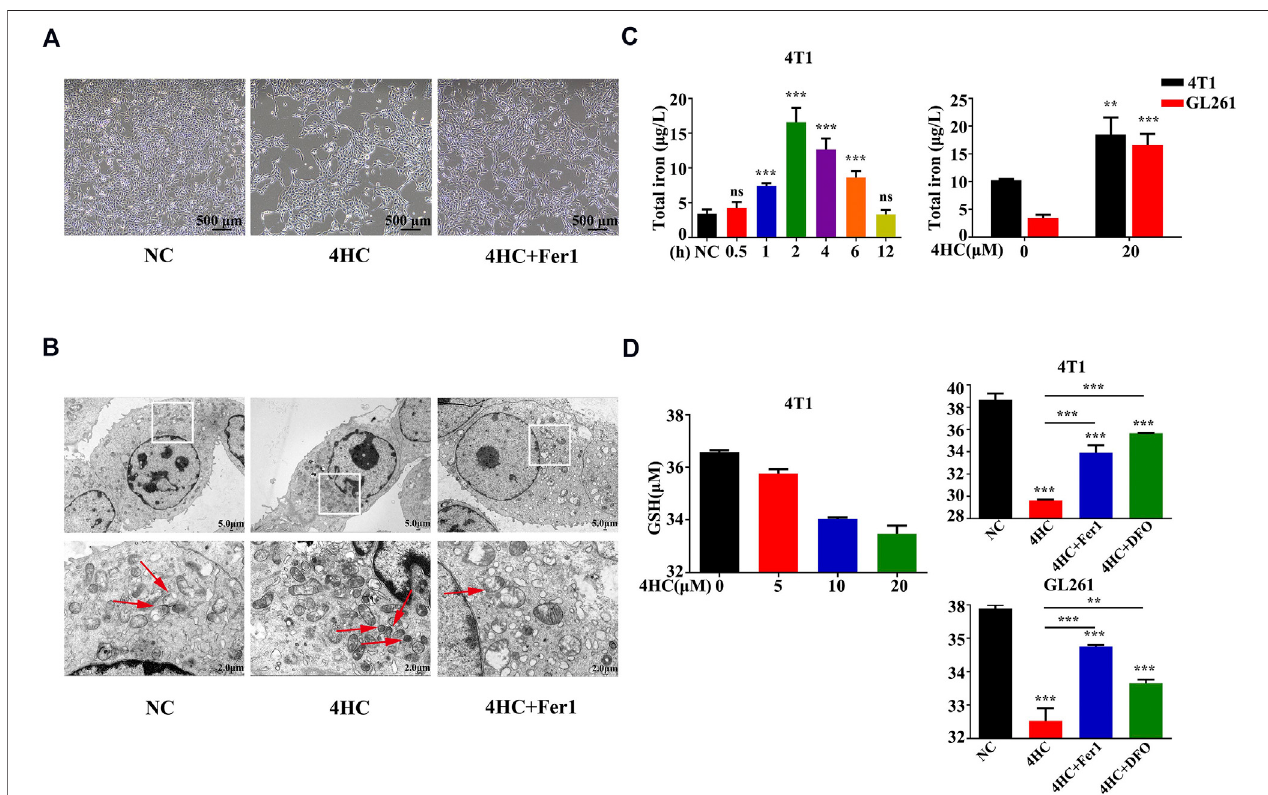
FIGURE 5 | Mitochondrial deformation and 4HC-induced alterations in GSH or iron levels were antagonized by ferroptosis inhibitors (A-B) TEM visualization of changes in mitochondrial morphology in 4T1 cells exposed to various experimental conditions. The red arrows indicate mitochondrial. Shown were representative images with similar results (scale bar = 2.0 μ m). (C) Intracellular iron concentrations in 4T1 and GL261 cells exposed to 4HC (20 μ M) for the indicated times were determinedusingICP – MS.Valuesarepresentedasthemeans±SDfromthreeindependentexperiments.ns,notsigni fi cant,** p < 0.01,and*** p < 0.001(one-way ANOVA analysis). (D) Intracellular GSH levels in 4T1 and GL261 cells exposed to the indicated conditions were determined. Values are represented as the means ± SD from more than three independent experiments. ** p < 0.01 and *** p < 0.001 (one-way ANOVA analysis) for the indicated